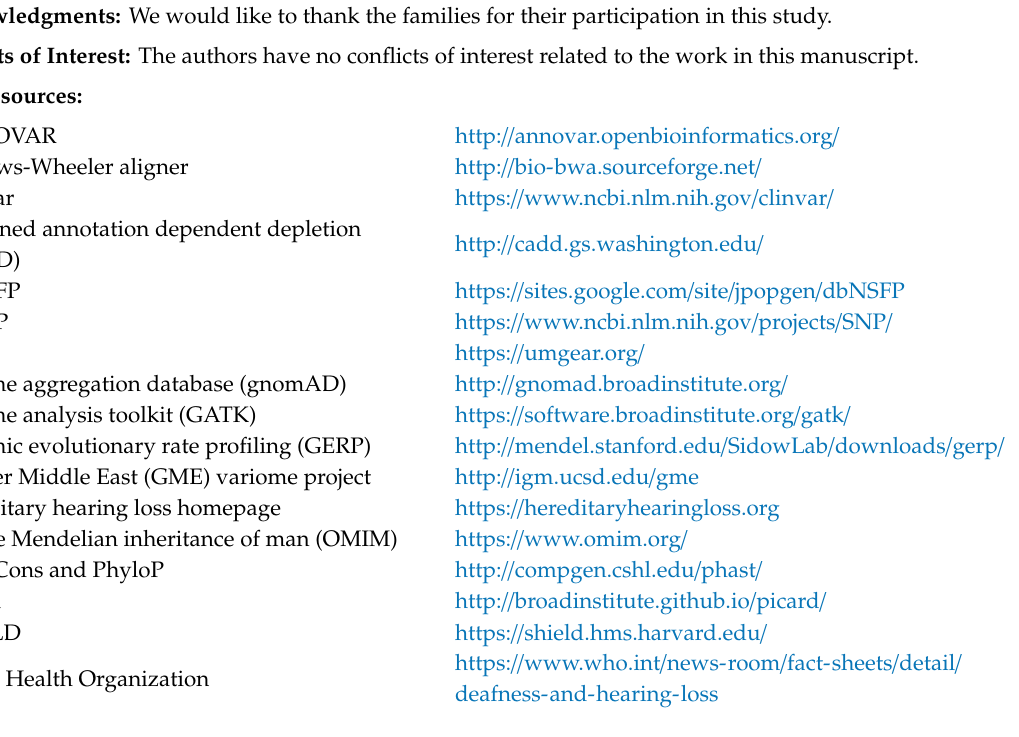
Table S1: Candidate variants identified in both families, genotypes and annotations. Figure S1: Sanger traces of the GREB1L variants in both